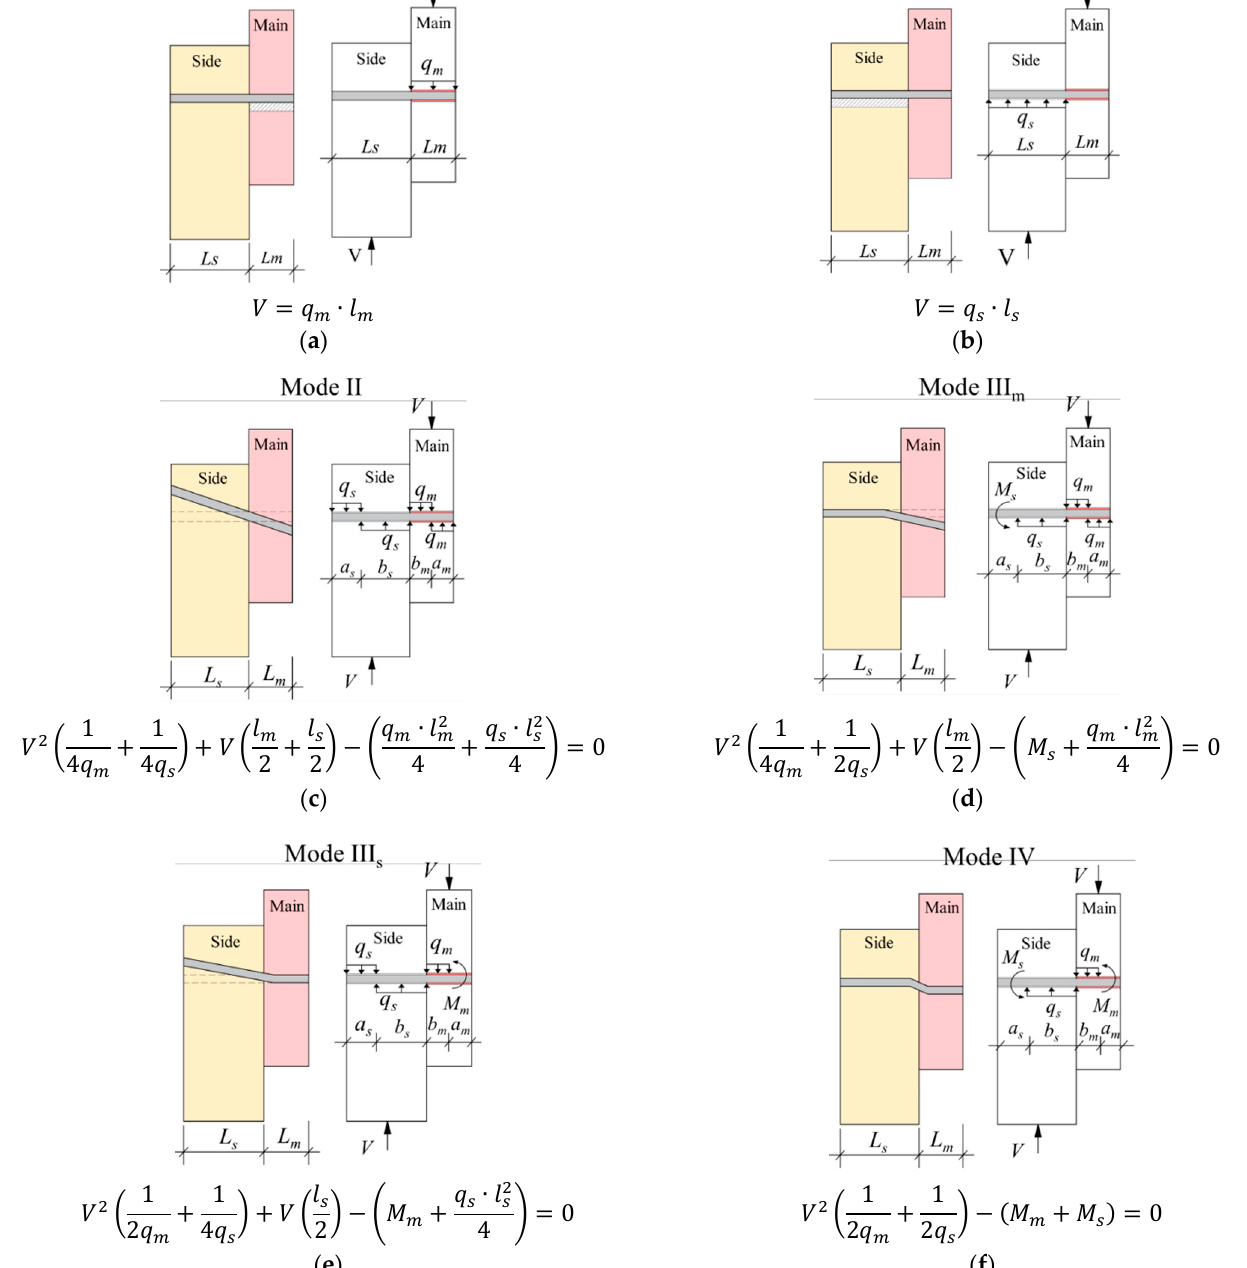
Figure 8. Yield modes and formula. ( a ) Mode I m ; ( b ) Mode I s ; ( c ) Mode II; ( d ) Mode III m ; ( e ) Mode III s ; ( f ) Mode IV where V is the shear force of the dowel type fastener (N), q m ( F m ·l m ) is the main member dowel-bearing resistance ( N/mm ), q s ( F s ·l s ) is the side member dowel-bearing resistance ( N/mm ), M m is the maximum moment in the main member ( N·mm ), and M s is the maximum moment in the side member ( N·mm).